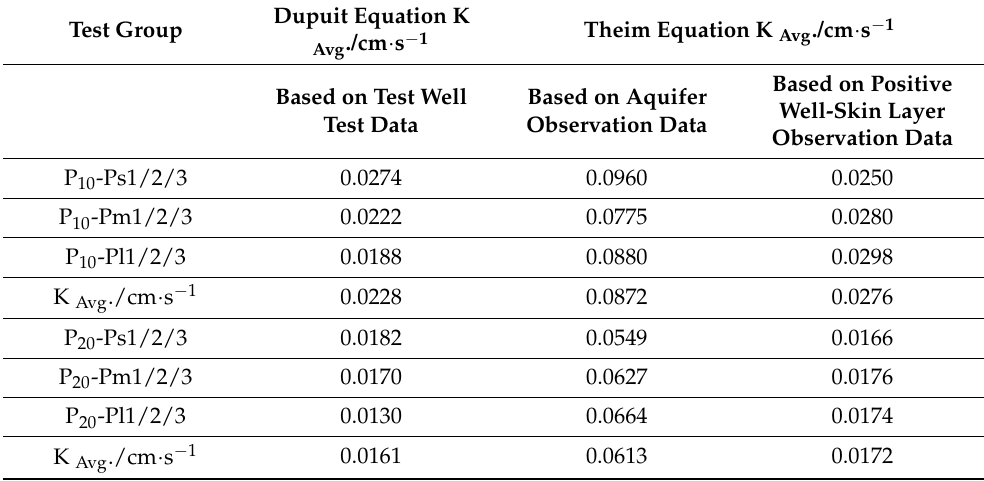
Table 3. Calculation of results permeability coefficients determined by pumping tests under positive well-skin model